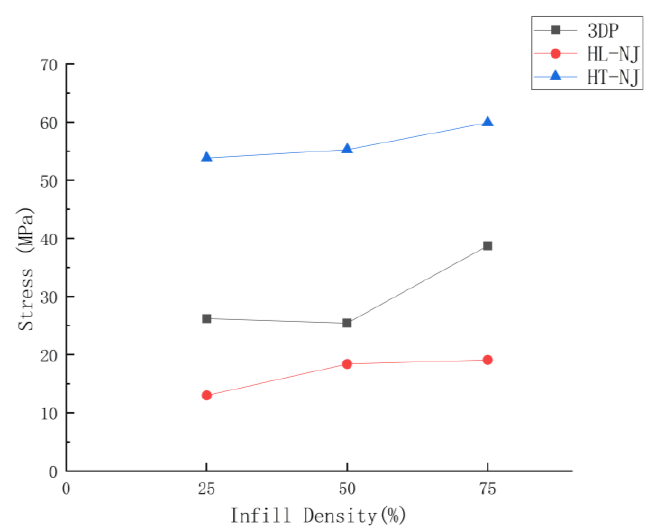
Figure 3. Graphical comparison of average stress value for the tensile samples as a function of infill density.